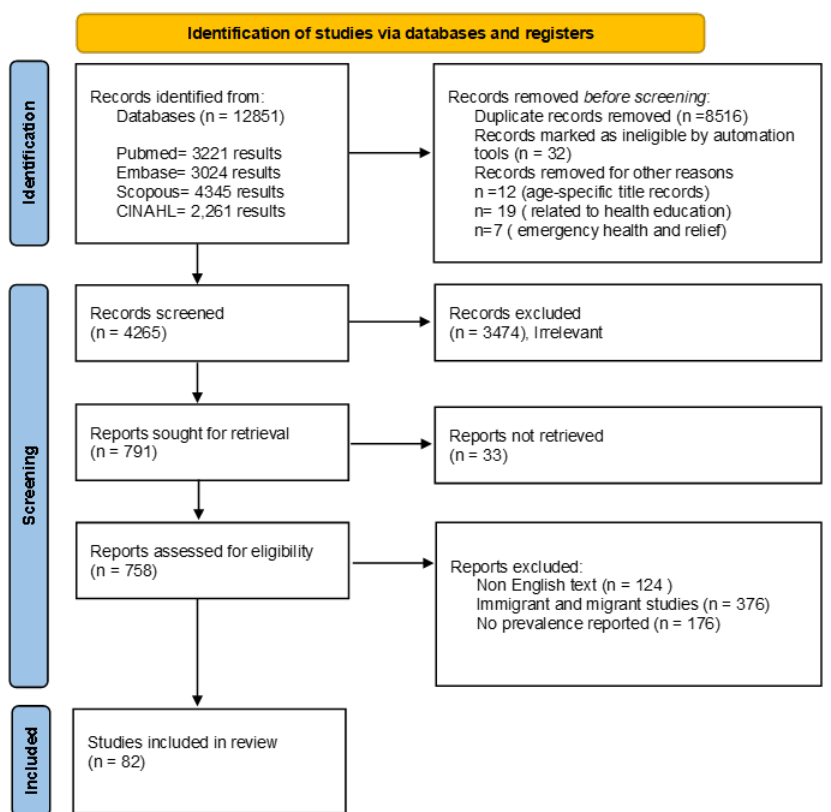
Figure 1. PRISMA flow chart study selection process.